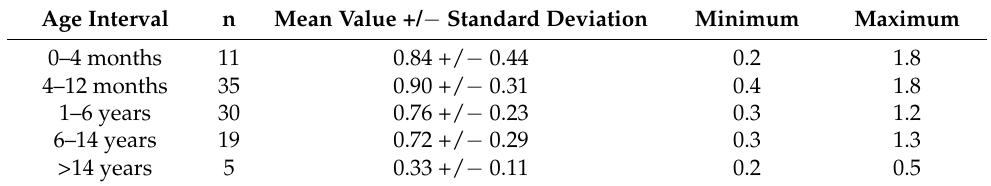
Table A1. Daily protein intake via natural protein (g/kg body weight).